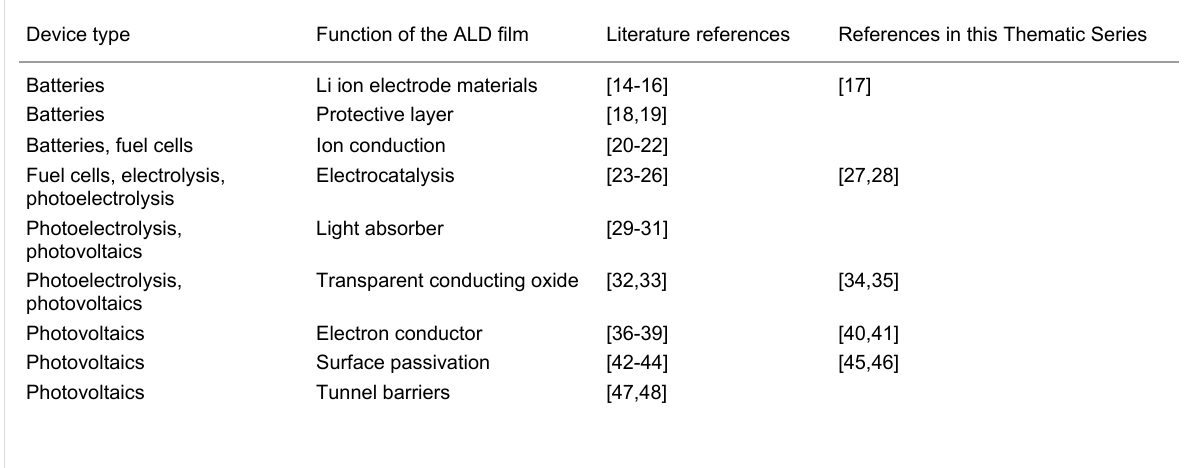
Table 1: A non-exhaustive list of exemplary ALD applications in energy conversion devices illustrated in this Thematic Series and in previous litera- ture. Reviews have been published recently on the applications of ALD in photovoltaics [11], lithium ion batteries [12], and solid oxide fuel cells [13].